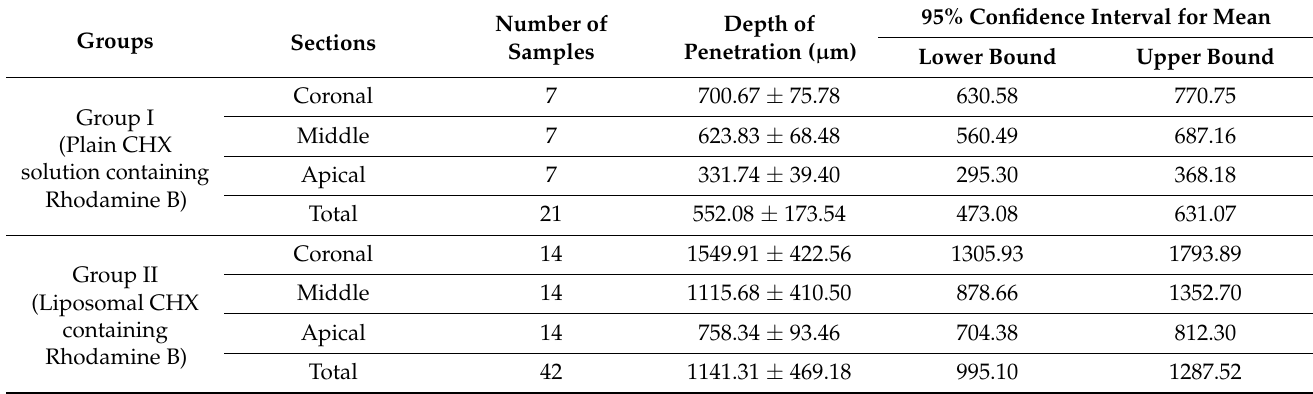
Table 2. Depth of penetration of plain CHX solution and liposomal CHX in dentinal tubules.